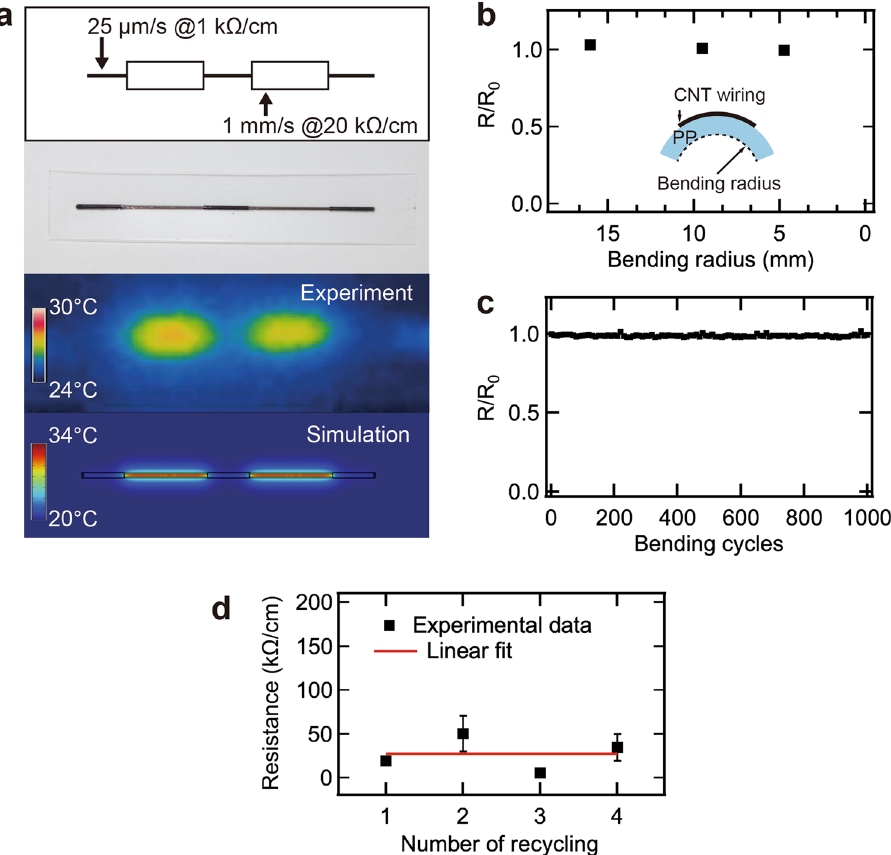
Figure 5. ( a ) Temperature map of MWNT wirings and simulation result with photograph and schematic diagram. ( b ) R / R 0 values with different bending radii. R 0 is the initial resistance. ( c ) Repeated bending test with a bending radius of 9.5 mm. ( d ) Resistance per cm as a function of number of